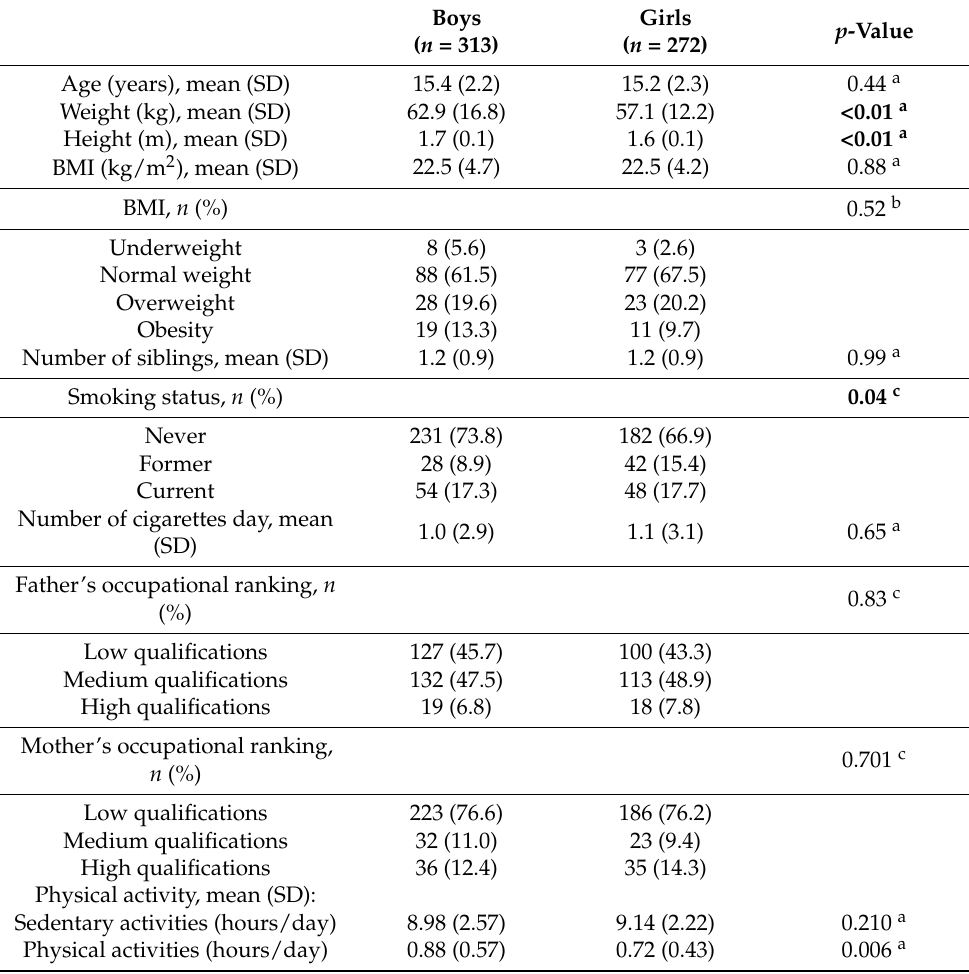
Table 1. Characteristics of the overall sample ( n =